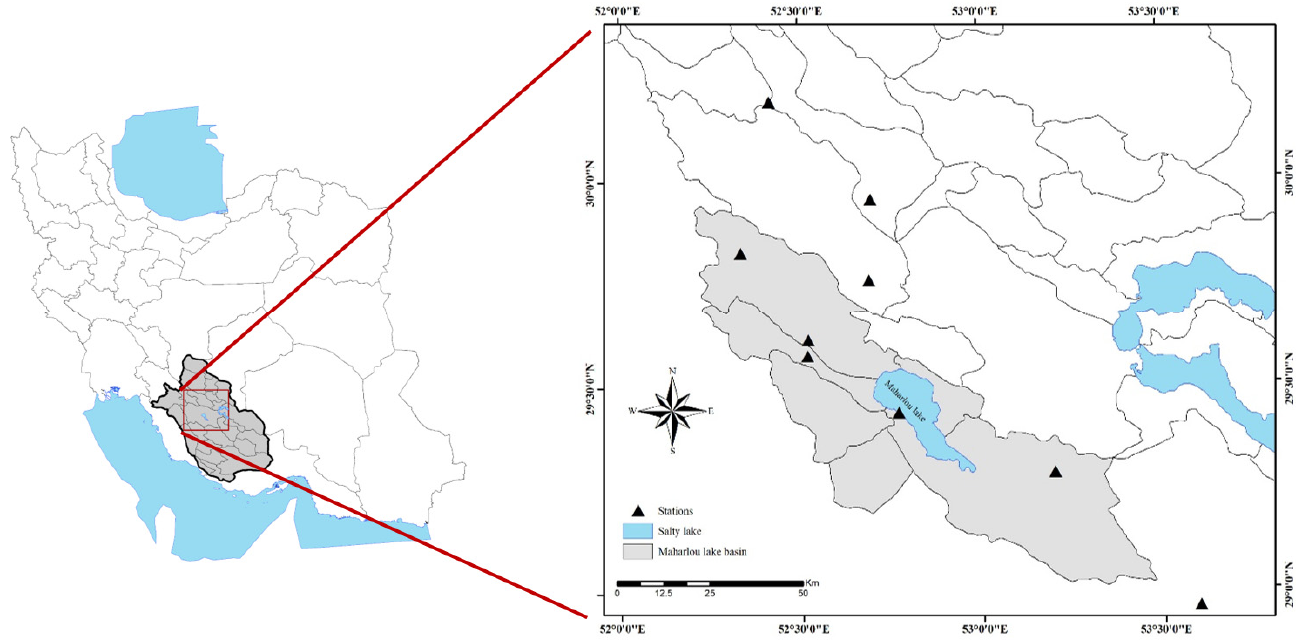
Figure 1. The location of the study area and selected weather stations.